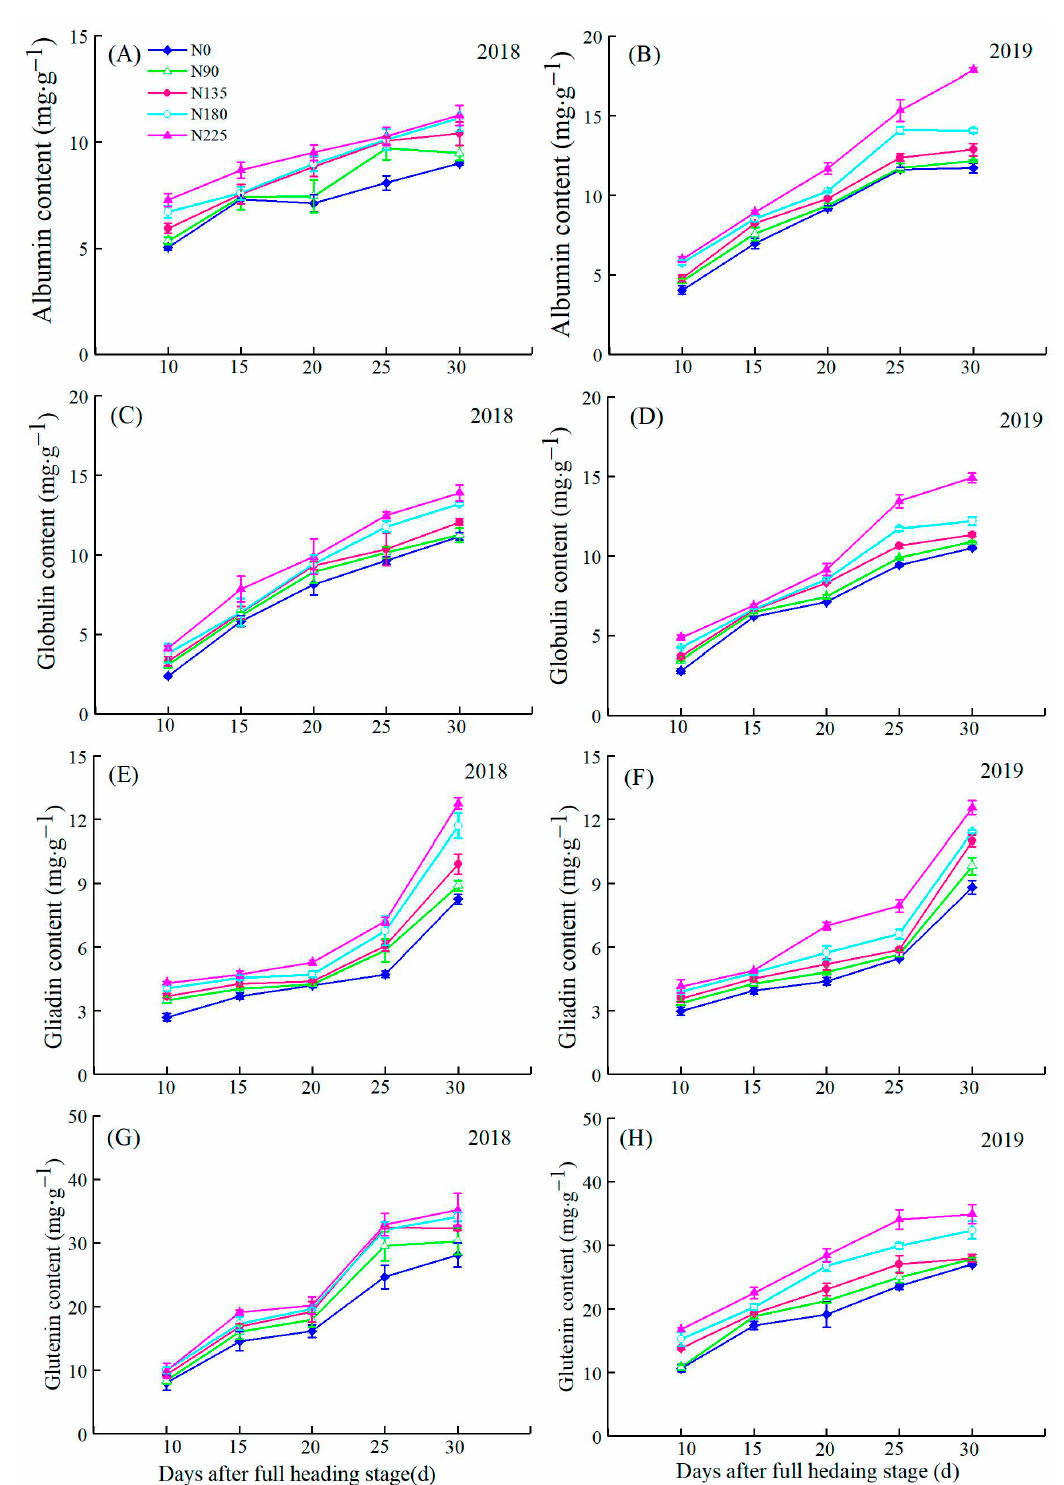
Figure 5. Effects of different nitrogen application amount on the change of albumin content ( A , B ), the globulin content ( C , D ), the gliadin content ( E , F ) and the Glutenin content ( G , H ) in rice.